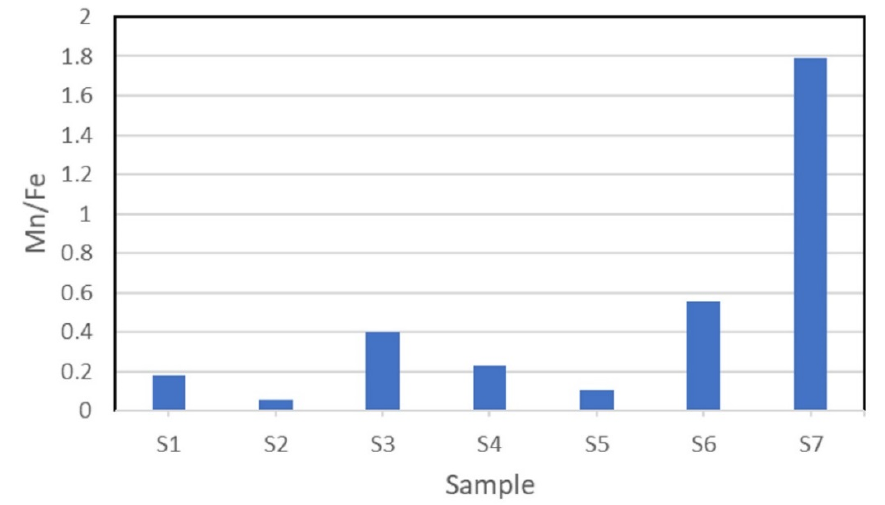
Figure 6. Manganese versus iron ratio for all pigment samples.